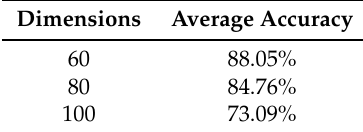
Table 6. Average accuracies of different dimensional Max-cut problems using the Biq Mac Library by